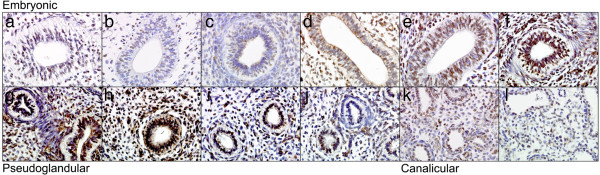
Immunohistochemistry of 5-HT4R in fetal lung tissue. Weak staining is apparent in early Embryonic stages which increases in intensity with age leading to strong staining in the Pseudoglandular and moderate staining in the Canalicular stages. a-l represent age ordered samples of 19 days (a, b), 21 days (c, d), 23 days (e, f), 10 weeks (g, h), 12 weeks (i, j), 17 weeks (k) and 19 weeks (l). All isotype controls were negative (data not shown). X40 magnification.